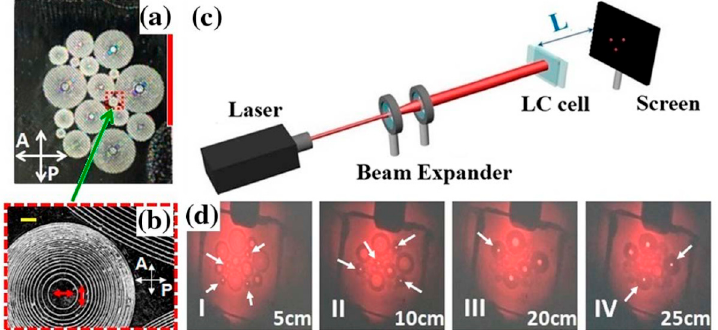
Figure 7. Photograph, micrograph, and characterization of the focal distances of the proposed LC smart glass prototype based on LC Fresnel lenses with randomly assigned focal lengths ( f = 2, 5, 10, 15, 20, 25, and 30 cm). ( a ) Photograph of the prototype captured under the crossed polarizer (P) and analyzer (A). The red scale bar corresponds to 1 cm. ( b ) Area of the smart glass, captured by the polarizing optical microscope (POM). Red arrows indicate that the orientations of LCs in odd and even zones are orthogonal to each other. Yellow scale bar corresponds to 100 µ m. ( c ) Schematic of the experimental setup for characterizing the focal distances of the prototype, and L is the distance between the screen and the LC cell. ( d ) Selected di ff raction patterns of the proposed LC smart glass prototype captured at L = 5, 10, 20, and 25 cm. The white arrows point to the corresponding focal points.